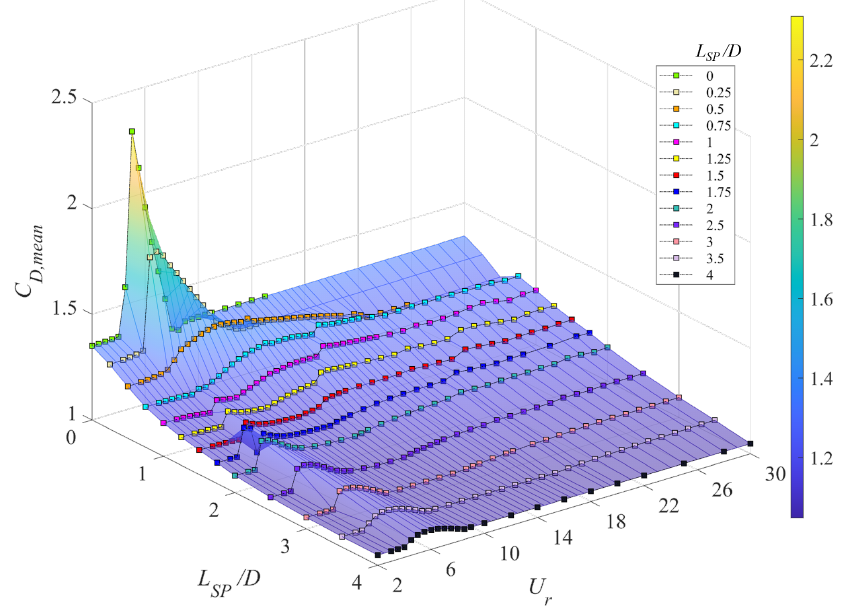
Figure 12. Three-dimensional plot of the time-averaged (mean) drag coefficient C D , mean as a function of the splitter-plate length L SP and the reduced velocity U r